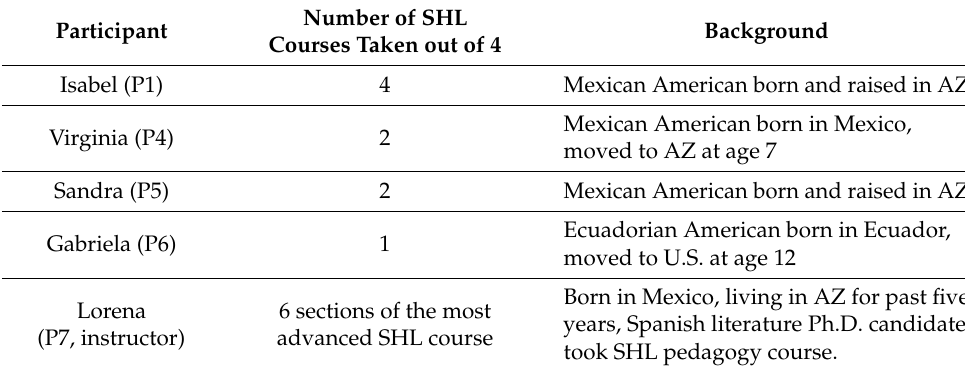
Table 1. Participants’ number of SHL courses and background information.